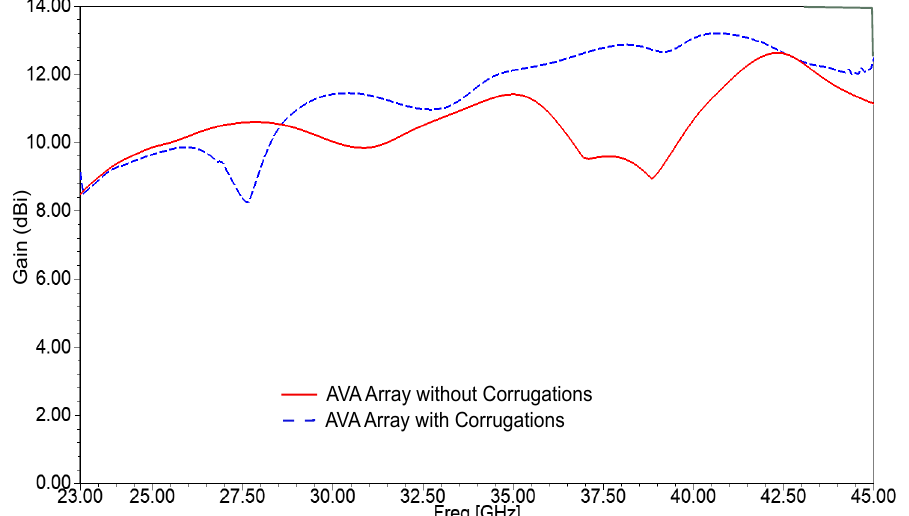
Figure 17. Simulated gain plots of the AVA array with and without corrugations.